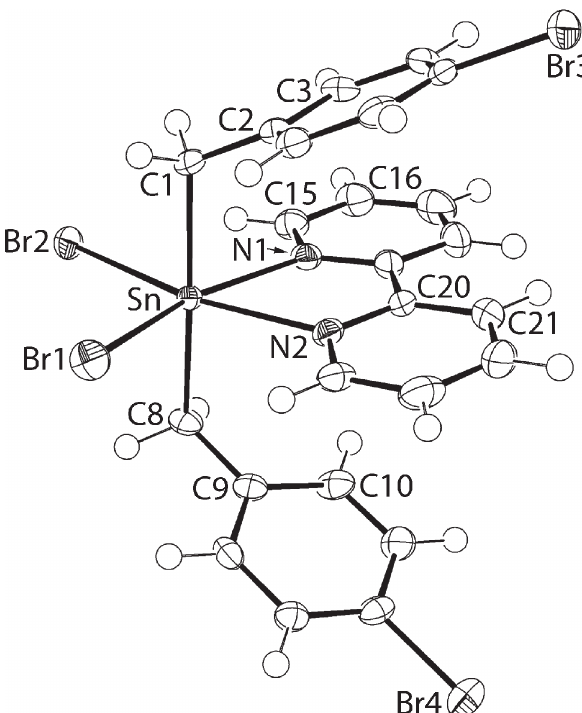
Table 1: Data collection and